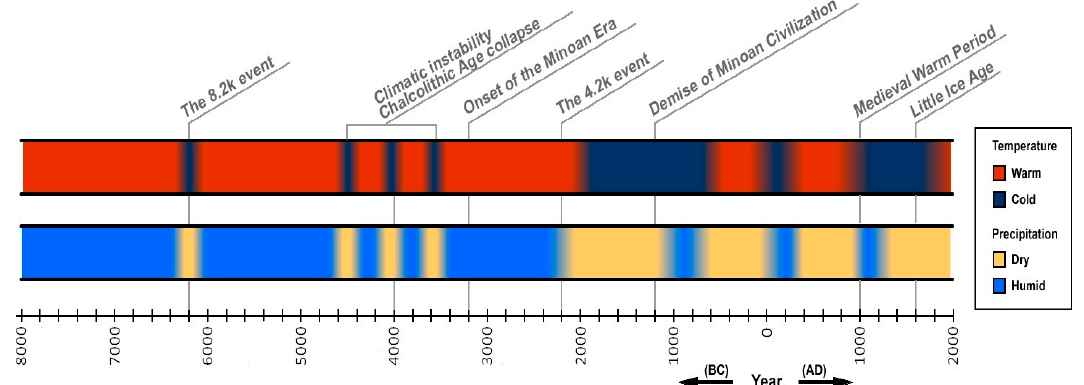
Figure 1. Climate reconstruction of Crete for the last 10 thousand years based on proxy and historical data (with permission from Markonis [18]).